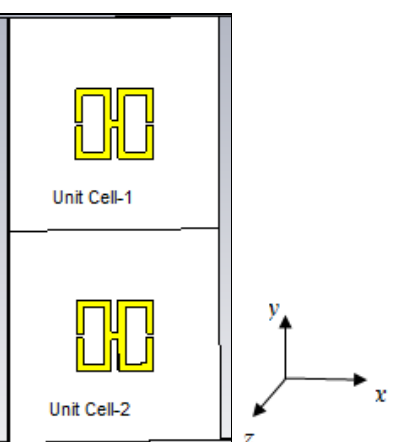
Figure 9. The 1 × 1 H-shaped unit cell.